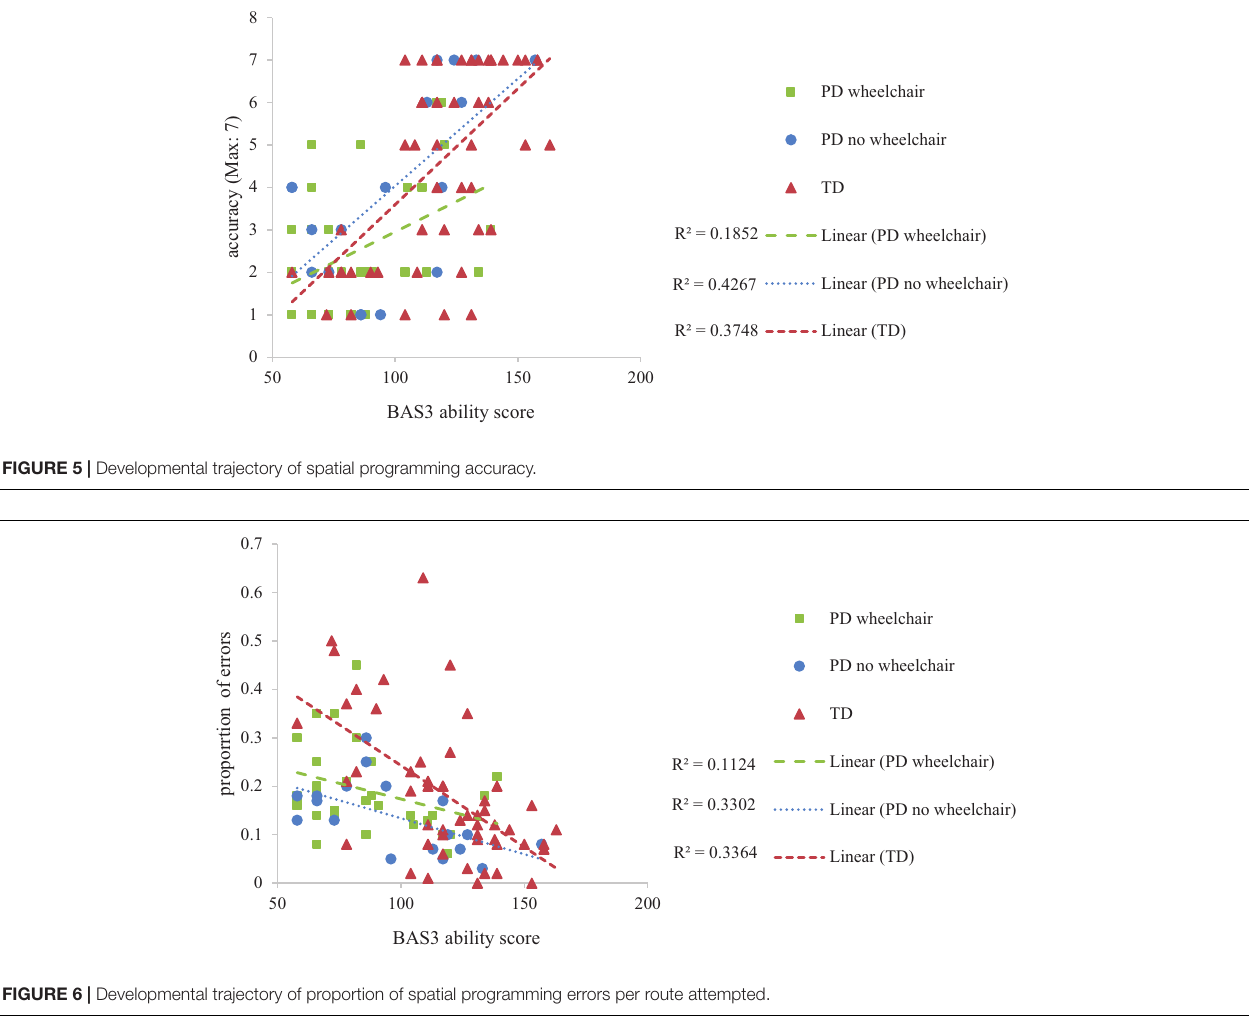
trajectories), F (2,94) = 2.529, p = 0.085, η p 2 = 0.051).